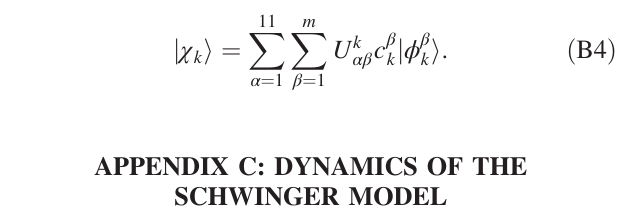
FIG. 11. Robustness of the spectral structure. Energy-momen- tum relation of eigenstates around E ¼ 0 for L ¼ 20 . For each eigenstate j ψ i , the color indicates the value of log 10 ðjh ψ j ϕ q ¯ q ijÞ (eigenstates with smallest overlaps are not plotted). The dispersion observed for m=w ¼ 0 in (a) is shifted but persists when we introduce a nonzero mass as in (b) and